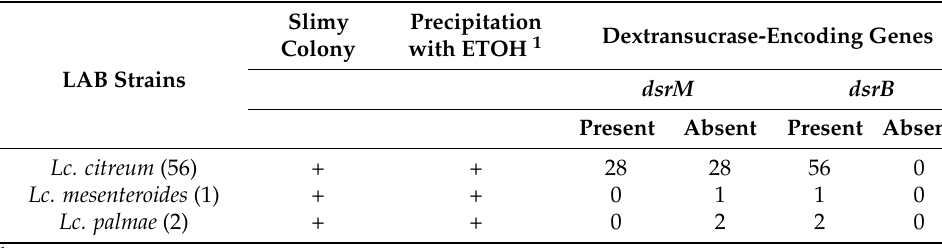
Table 5. EPS production of 59 Leuconostoc sp. strains on MRS supplemented with sucrose (40